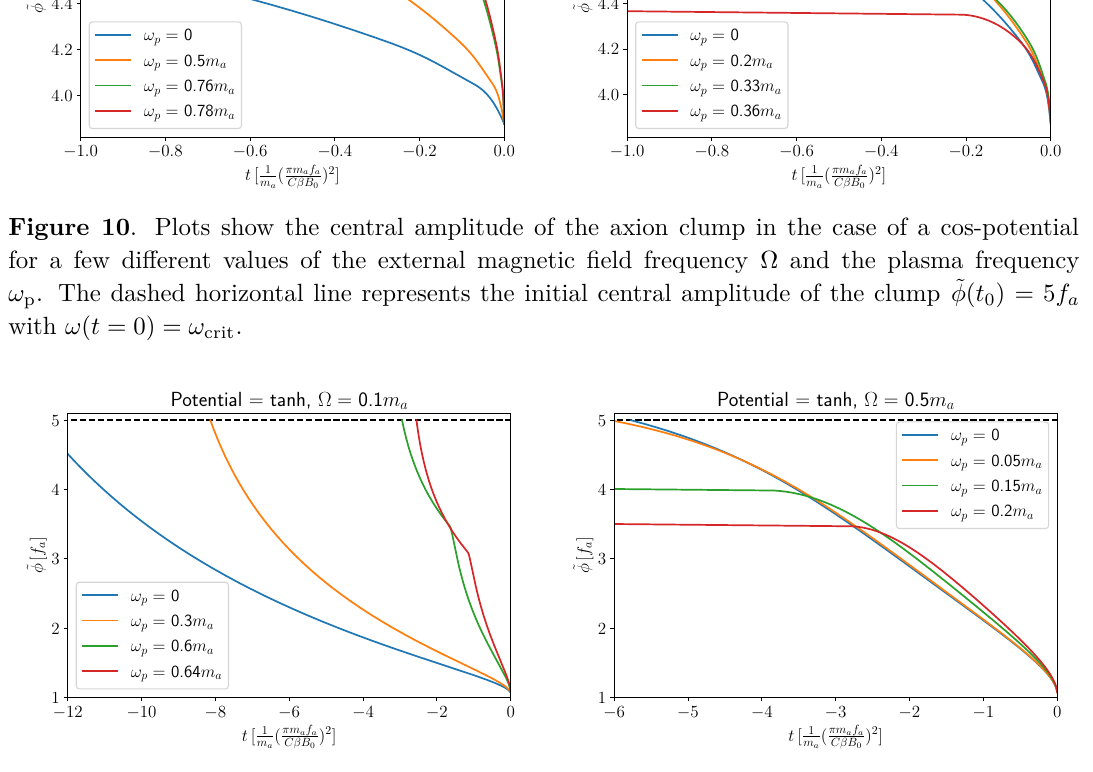
Figure 11 . Central amplitude of the axion clump in the case of a tanh-potential for a few differ- ent values of the external magnetic field frequency Ω and the plasma frequency ω p . The dashed horizontal line represents the frequency with the initial central amplitude of the clump ˜ φ ( t 0 ) = 5 f a with ω ( t = 0) = ω crit